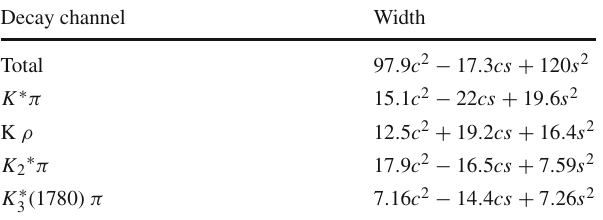
Table 12 The strong decay widths of K ∗